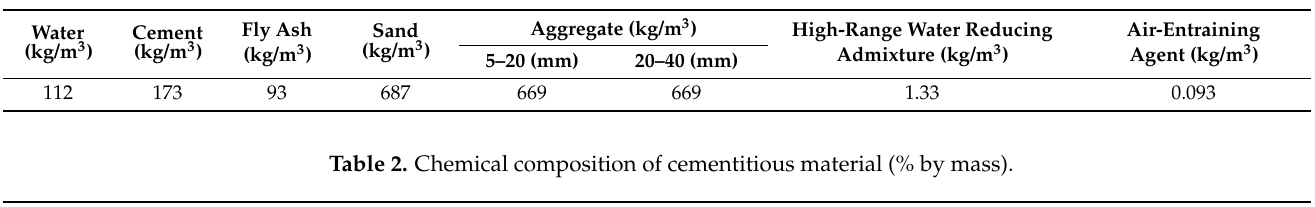
Table 1. Mixture proportion of dam gallery concrete.